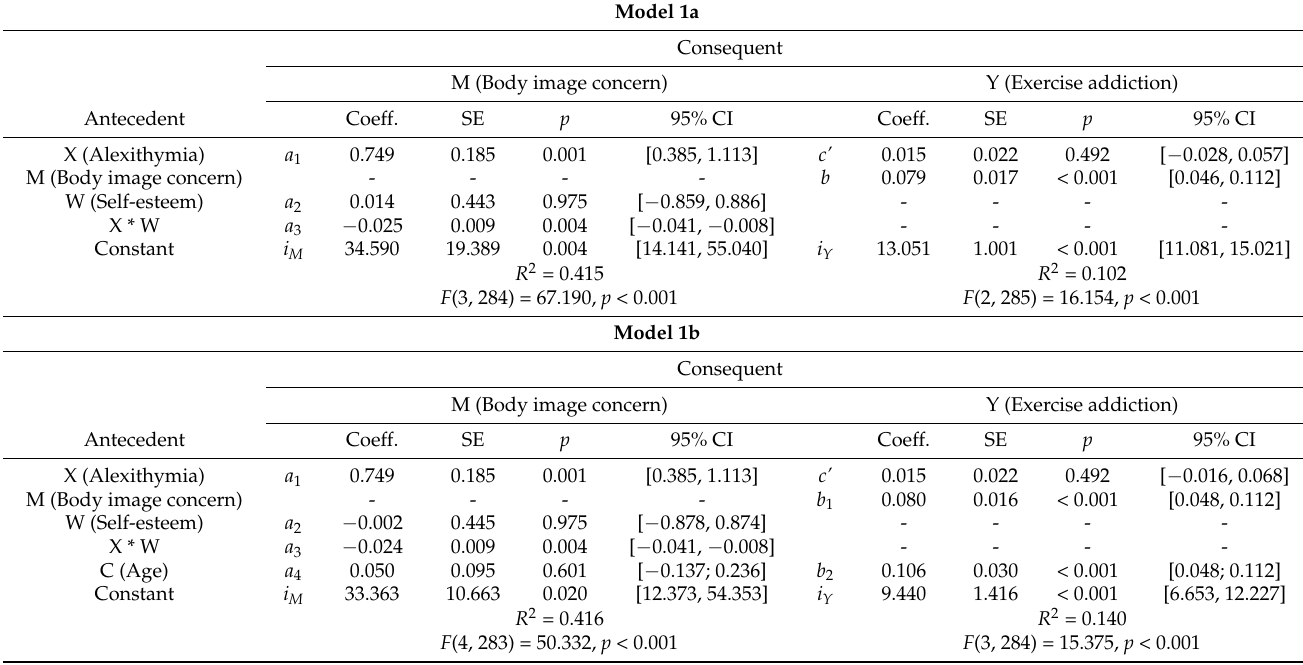
Table 3. Coefficients of the